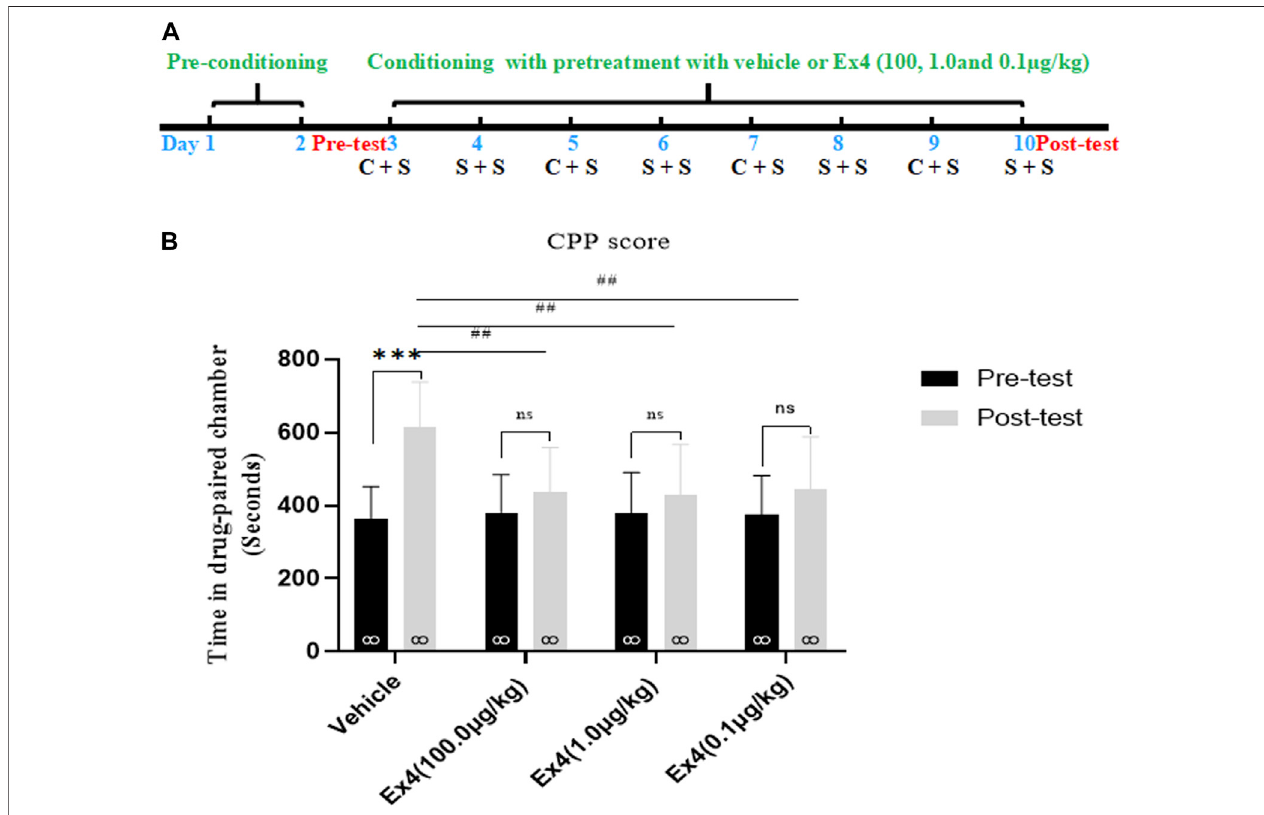
FIGURE 1 | Ex4 ’ s pretreatment prevents the acquisition of cocaine-induced CPP. (A) The experimental schedule for saline (S) as well as cocaine (C) and Ex4 treatments. (B) CPP scores following systemic treatment with vehicle and Ex4 (100, 1.0, and 0.1 μ g/kg) during cocaine conditioning show that cocaine induced a signi fi cantCPP thatwaspreventedbyEx4pretreatment.***represents p < 0.001vspretest, nsrepresents nosigni fi cantdifference,pairedt-test. ## represents p < 0.01 vs vehicle, one-way ANOVA followed by a Dunnett ’ s post hoc test. All data are presented as the mean ± SEM.